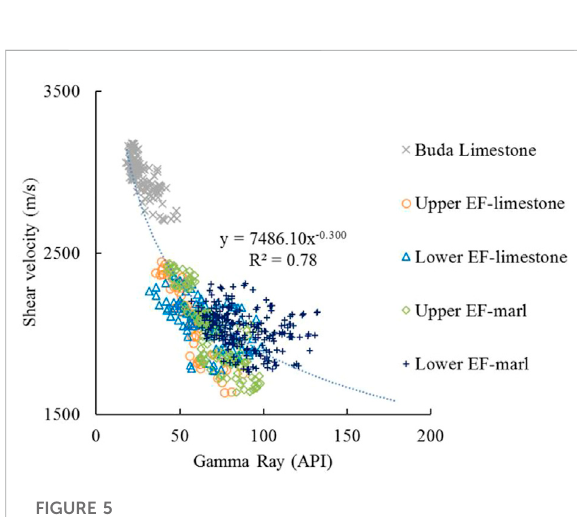
FIGURE 5 Correlations of shear velocity and gamma ray in different